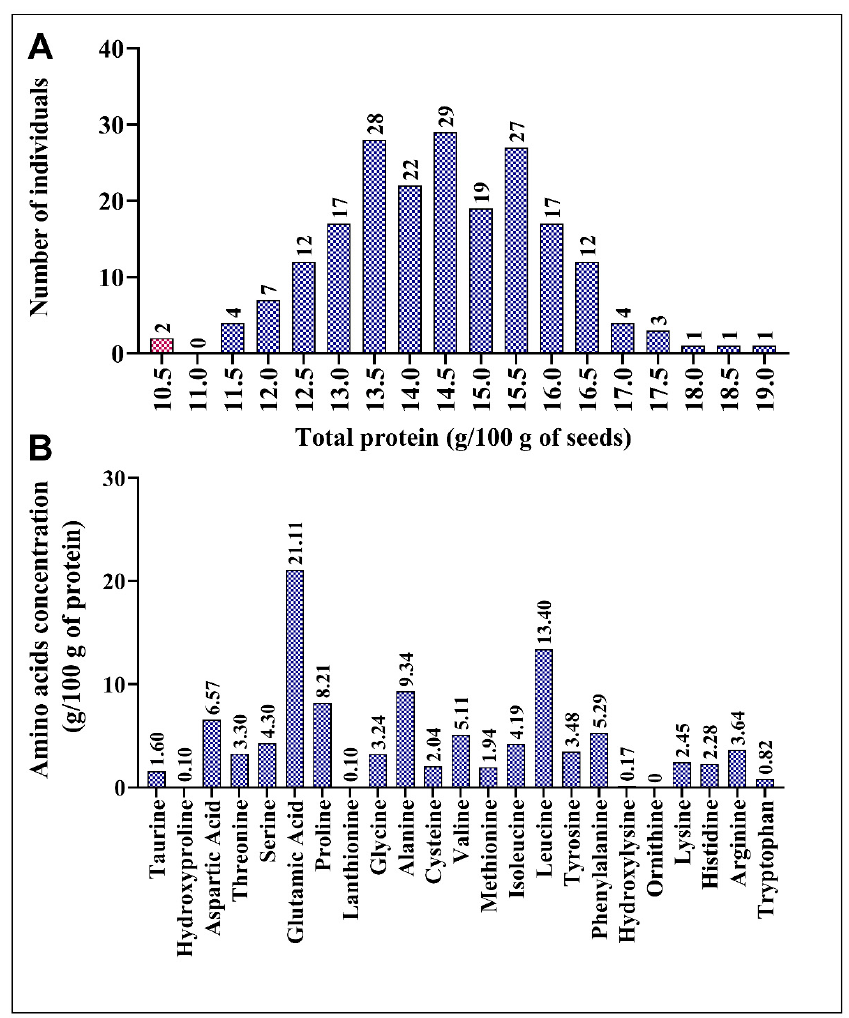
Figure 1. Variations in the total protein content in the mutant population and amino acid distribution in BTx623. ( A ) Variation in the total protein content and number of mutant lines. ( B ) Composition of amino acids in the total protein of BTx623. Control line (BTx623) is indicated by a red bar in each